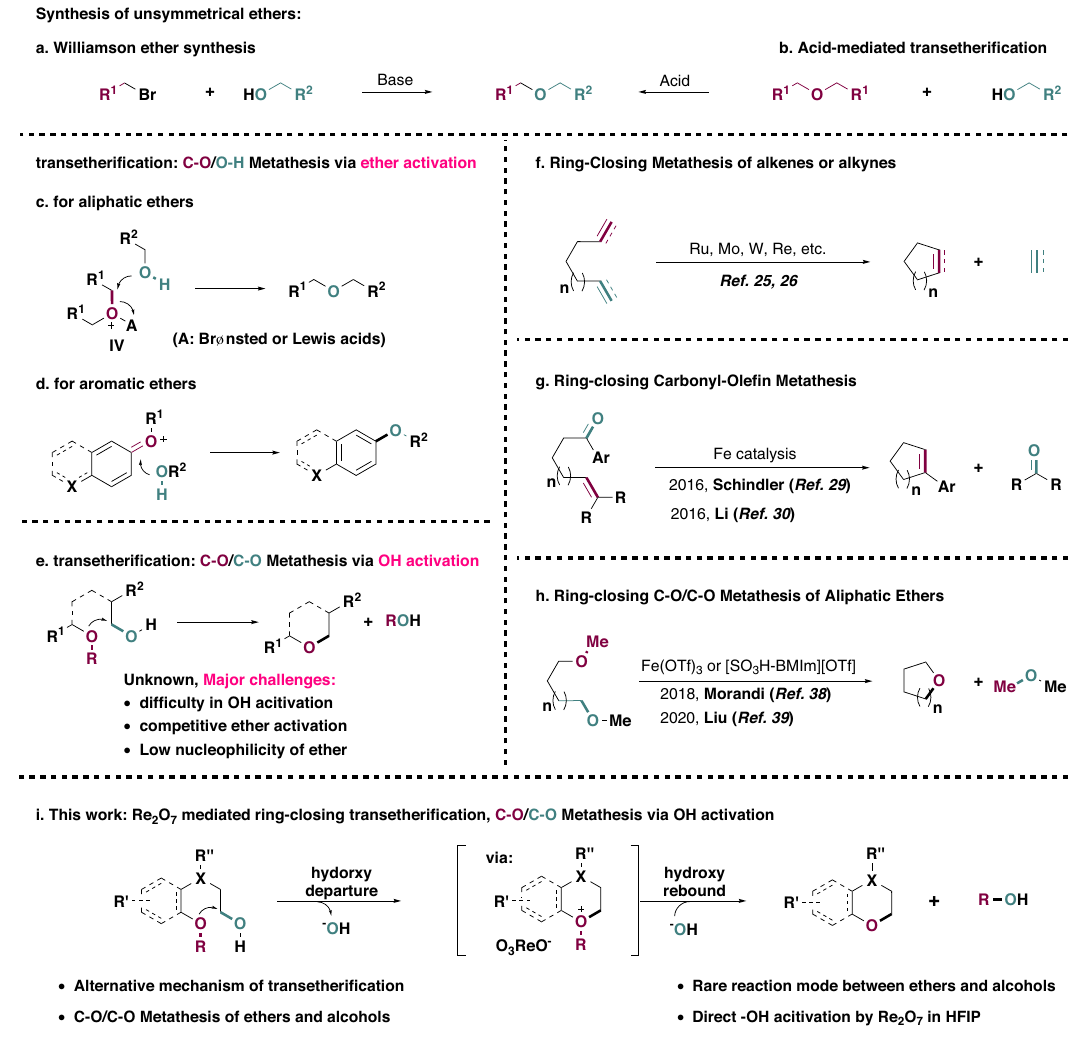
Fig. 1 | Synthesis of unsymmetrical ethers and transetheri fi cation reactions. a Williamson ether synthesis. b Acid mediated transetheri fi cation reactions. c Mechanismofacidmediatedtransetheri fi cationforaliphaticethers. d